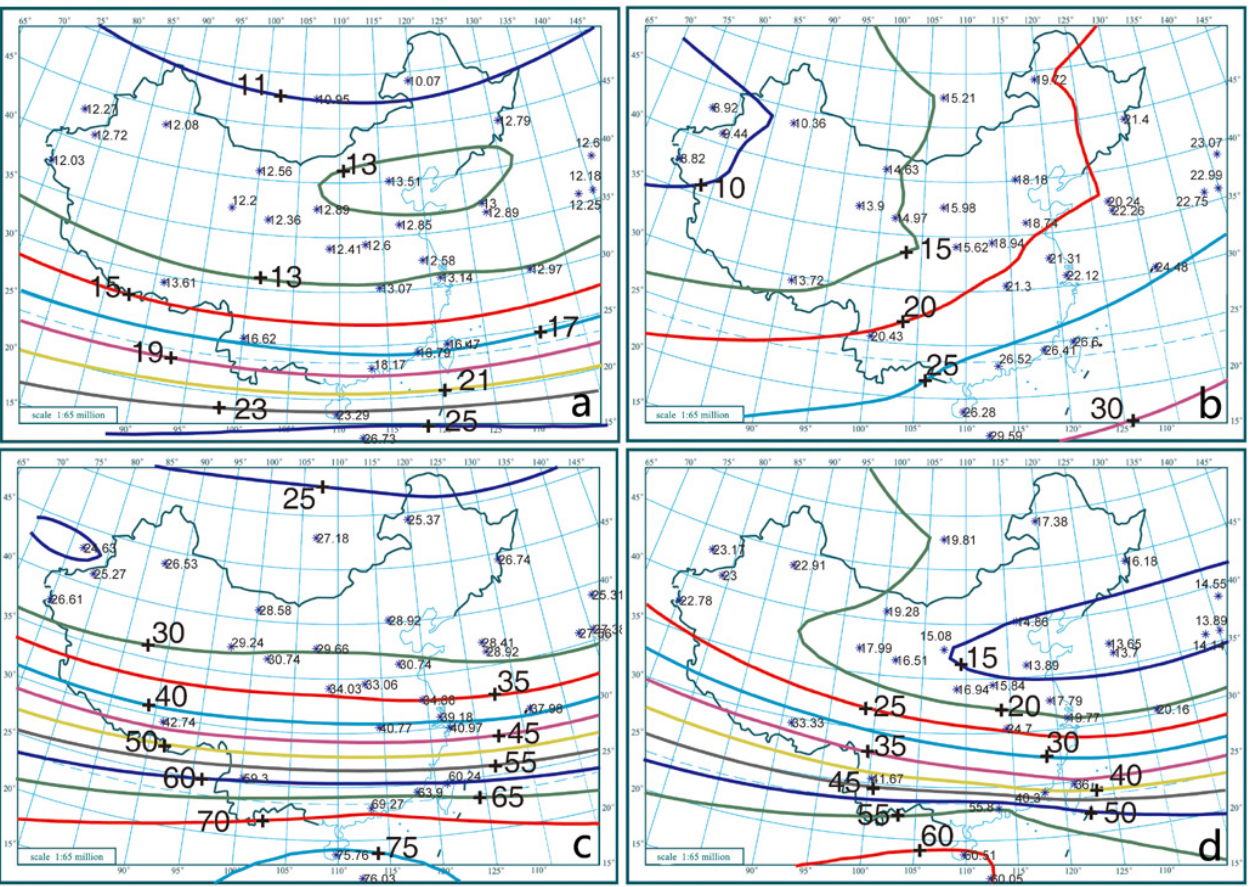
Fig. 2. TEC contour maps over China at four times on 20 March 2004. Unit: TECu. (a) 02:00BST; (b) 08:00BST; (c) 14:00BST; (d)